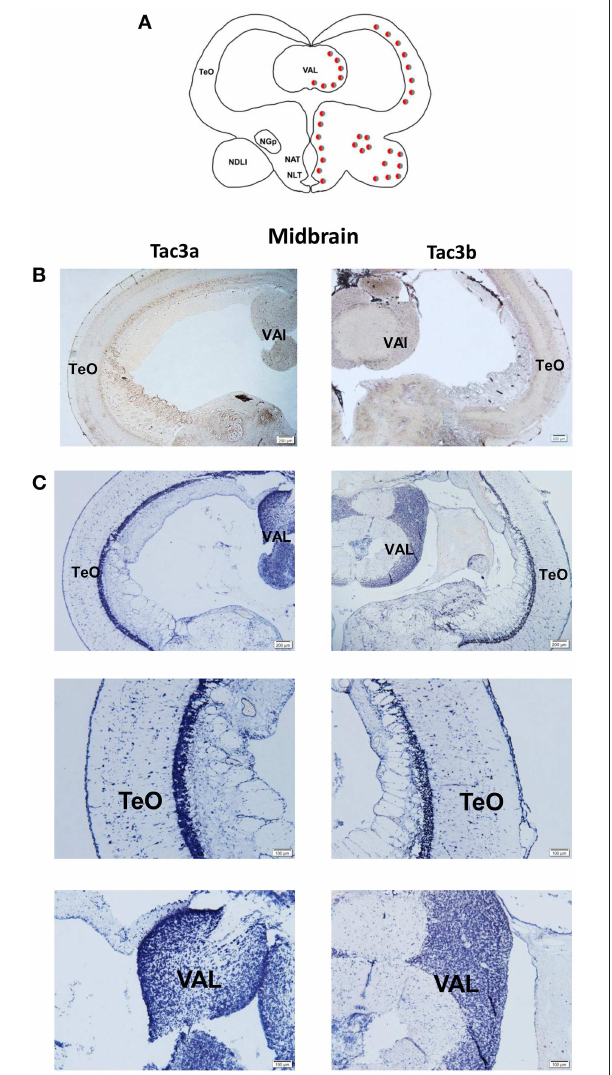
FIGURE 7 | Photomicrographs and schematic illustrations of the mRNA levels of tac3s in the midbrain of the spotted sea bass, as detected by in situ hybridization (ISH). Schematic drawings of spotted sea bass midbrain (A) . Photomicrographs of tac3a and tac3b sense probe results in the midbrain (B). Positive signal of tac3a and tac3b in the midbrain (C) . Abbreviations: TeO, tectum opticum; Val, lateral division of the valvula cerebella. Red and gray dots represent the locations of tac3a and tac3b ,